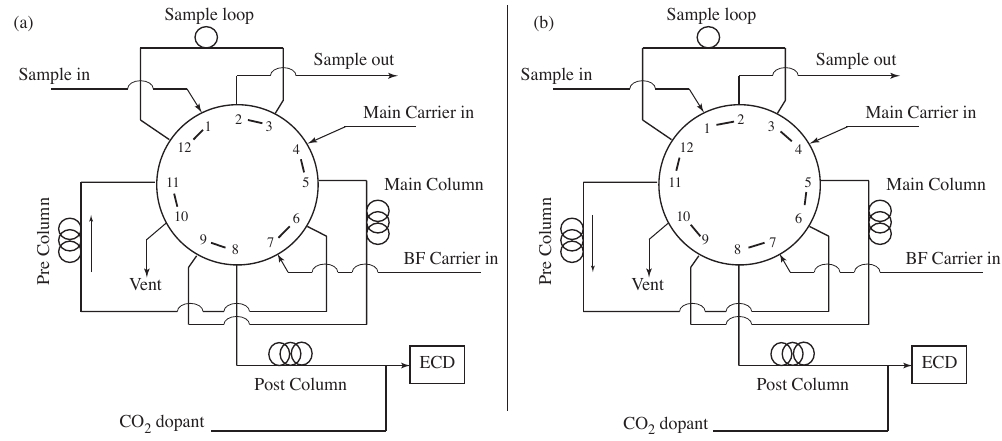
Fig. 1. Diagram of 12-port gas sample valve (GSV) in (a) load, and (b) inject modes. Note that Air (O 2 /N 2 ) is vented during inject mode, and the sample is directed from the main and post columns to the ECD in load mode.